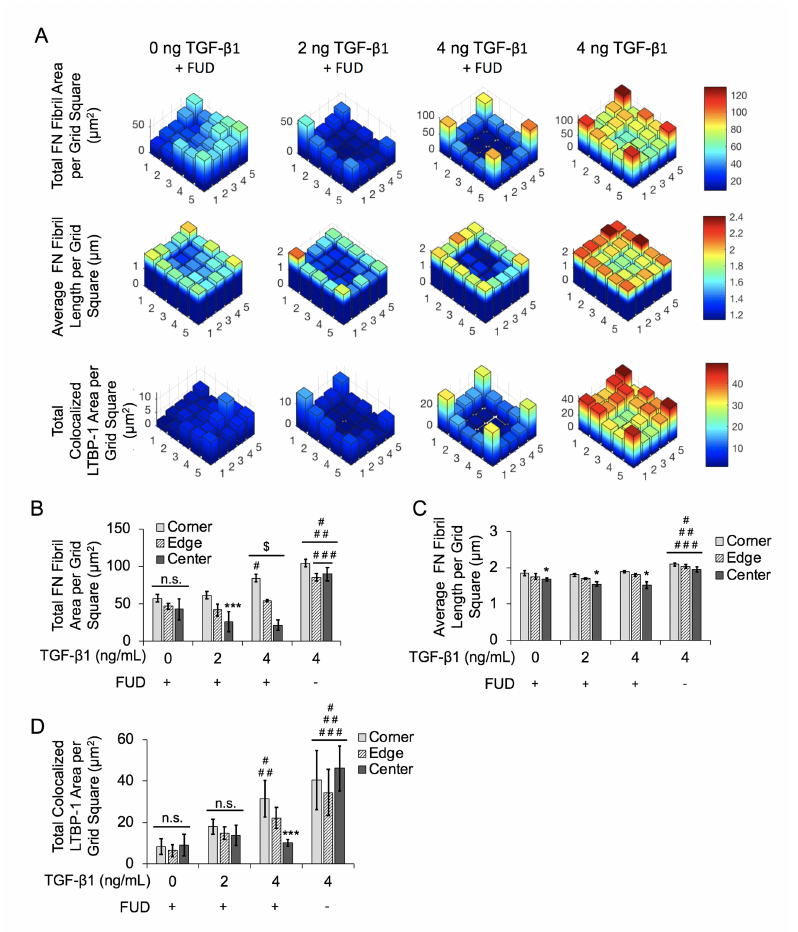
Figure 8. Inhibition of FN fibrillogenesis reduces effects of spatial gradients of FN fibril area, FN fibril length, and LTBP-1 colocalization with FN fibrils in MCF10A square islands with increasing concentrations of TGF- β 1. ( A ) Representative frequency maps of total FN fibril area per grid square, average FN fibril length per grid square and total colocalized LTBP-1 per grid square. ( B ) Quantifica- tion of total FN fibril area per grid square based on TGF- β 1 concentration and square location. N = 3 for each condition. ( C ) Quantification of average FN fibril length per grid square based on TGF- β 1 concentration and square location. N = 3 for each condition. ( D ) Quantification of total LTBP-1 colocalized area per grid square based on TGF- β 1 concentration and square location. N = 3 for each condition. n.s., not significant, * p ≤ 0.05 significantly different from both edge and corner within given concentration, *** p ≤ 0.05 significantly different from only corner within given concentration, $ p ≤ 0.05 significantly different from all other locations within given concentration, # p ≤ 0.05 sig- nificantly different from corresponding location in 0ng/mL TGF- β 1 only, ## p ≤ 0.05 significantly different from corresponding location in 2 ng/mL TGF- β 1 only, ### p ≤ 0.05 significantly different from corresponding location in 4 ng/mL TGF- β 1 only. p -values based on Bonferroni’s post-hoc multiple comparisons test following two-way